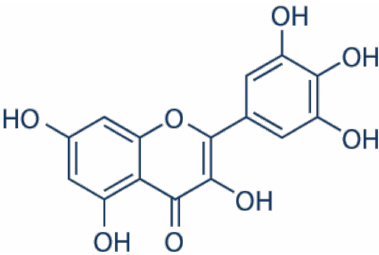
Figure 8. The chemical structure of myricetin.